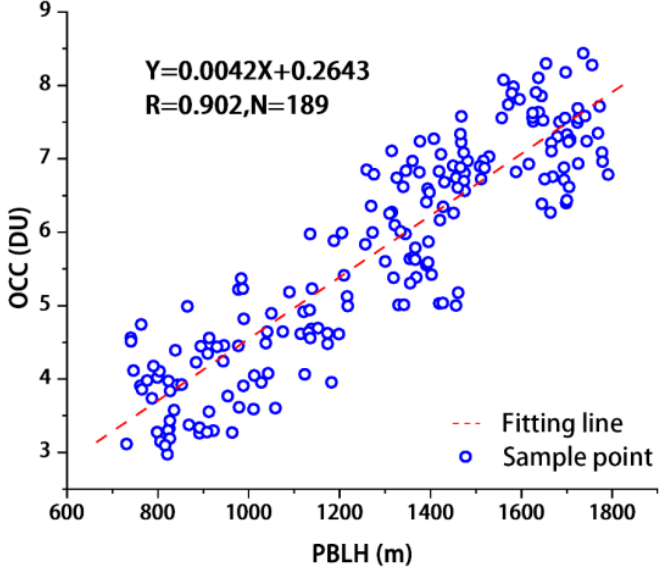
Figure 14. Scatter plot of monthly mean values of OCC LT and PBLH in China from 2005 to 2020.